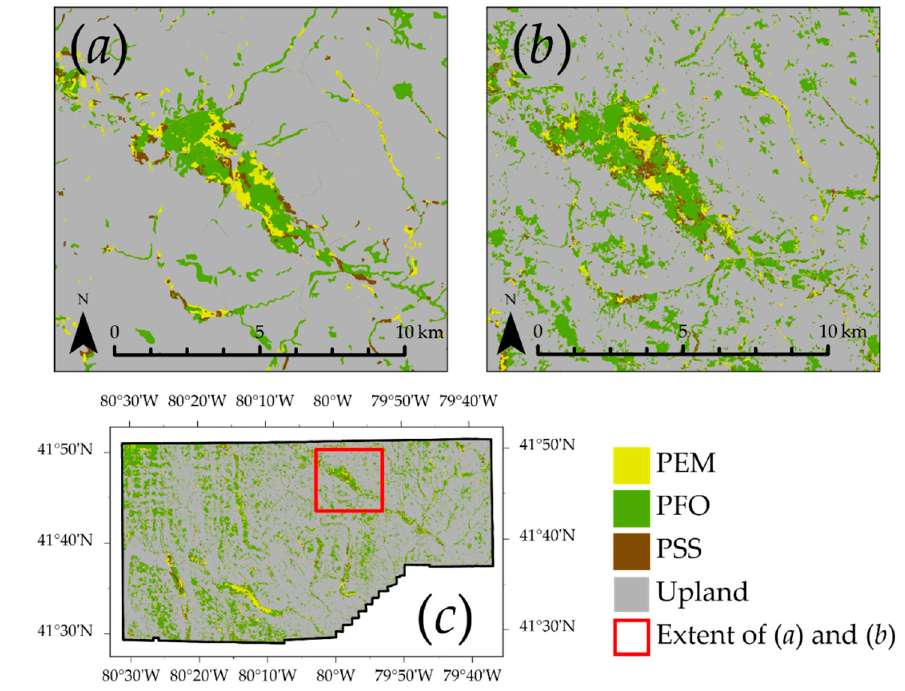
Figure 11. Palustrine wetland data for Crawford County, Pennsylvania, as an example of a multiclass assessment: ( a ) shows an example of the NWI data over a subset of the county, ( b ) shows the SAL data for the same subset, and ( c ) indicates the extent of ( a ) and ( b ) in the county. The data are projected to NAD83 UTM Zone 17 North.